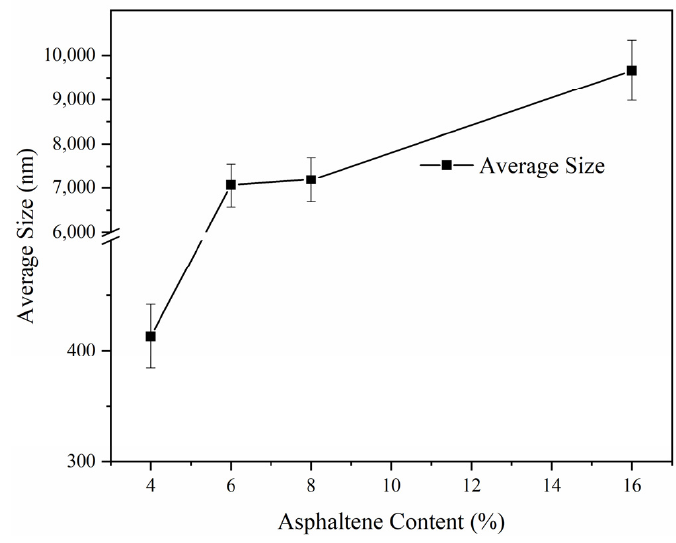
Figure 9. Average size of the solid particle emission.